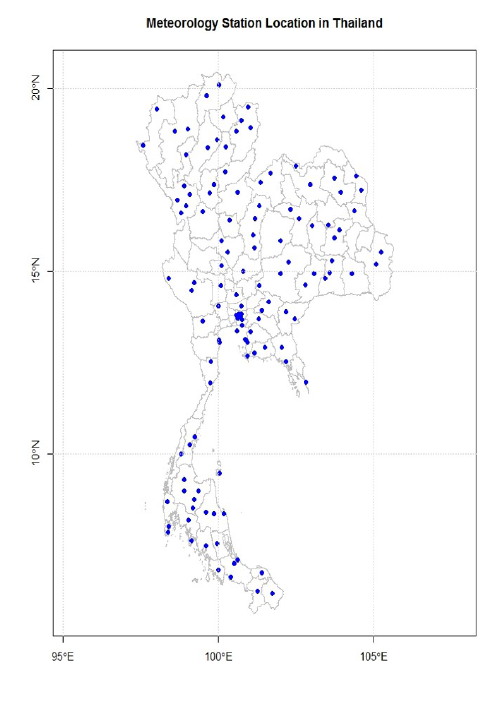
Figure 11. Location of measurement stations in Thailand.